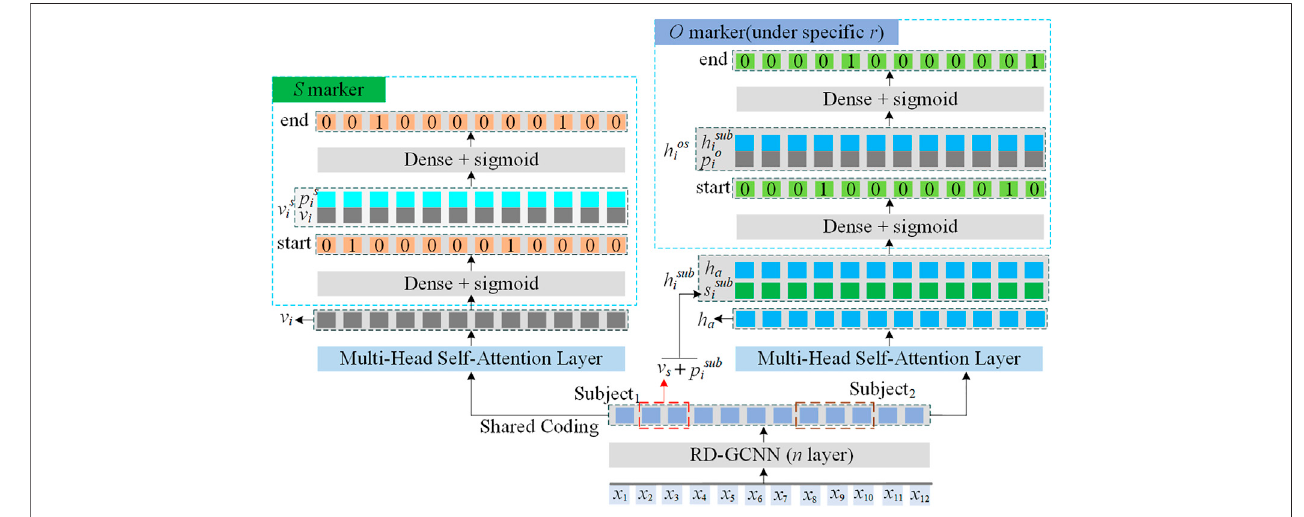
FIGURE 1 | Triple extraction based on the RD-GCNN-ATT model.